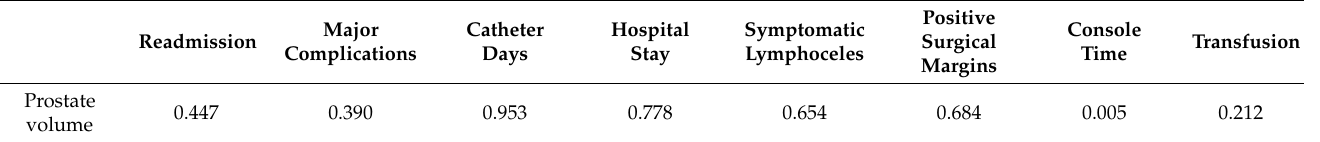
Table 4. Univariate linear and logistic regression analysis to predict readmissions and other postoper- ative